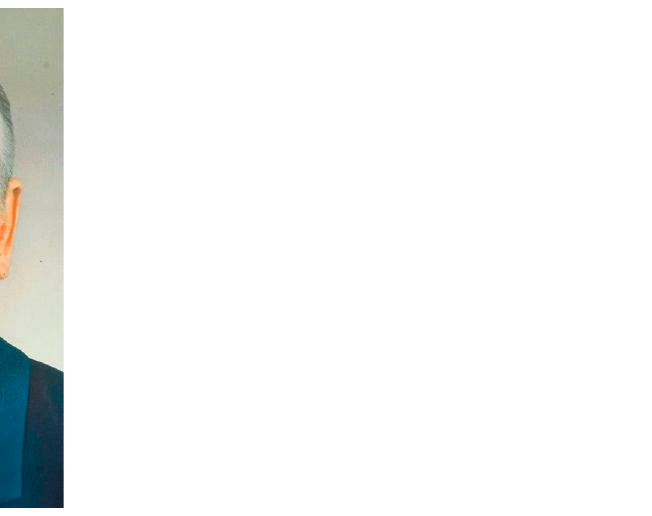
Figure 1. Vlad Mamyshev-Monroe. “M.S. Gorbachev” (1989). https://vmmf.org/series/view?id=47 (accessed on 11 September 2022).